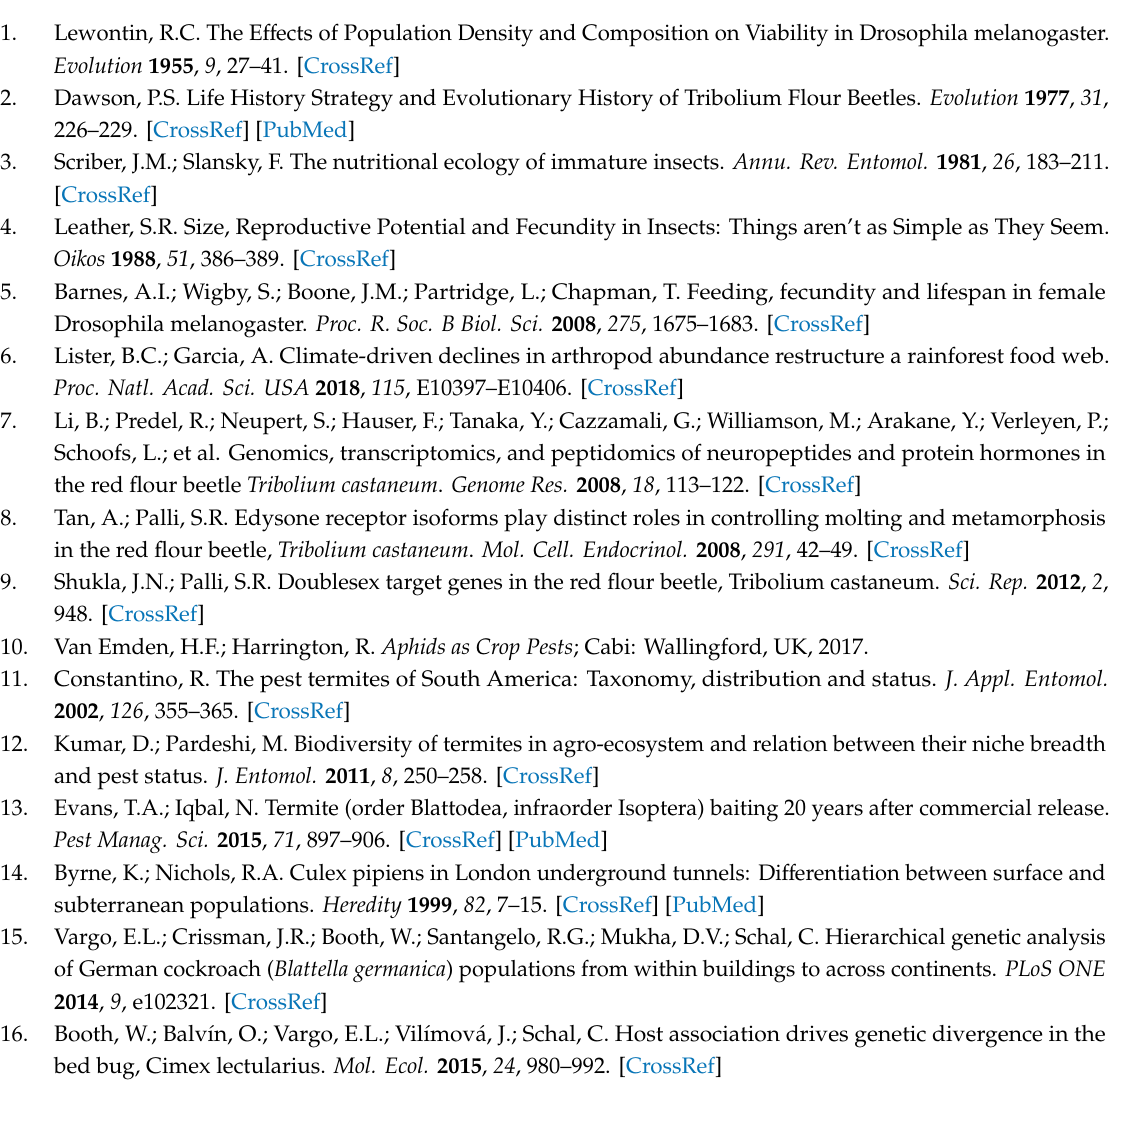
Table S1: GO terms and the number of L. hesperus ovarian transcripts per GO category; Table S2: KEGG pathway annotations for L. hesperus ovarian transcriptome; Figure S1: Gene Ontology (GO) level distribution of transcripts in the L. hesperus ovarian transcriptome, Figure S2: Purine and thiamine metabolism pathways in the L. hesperus ovarian